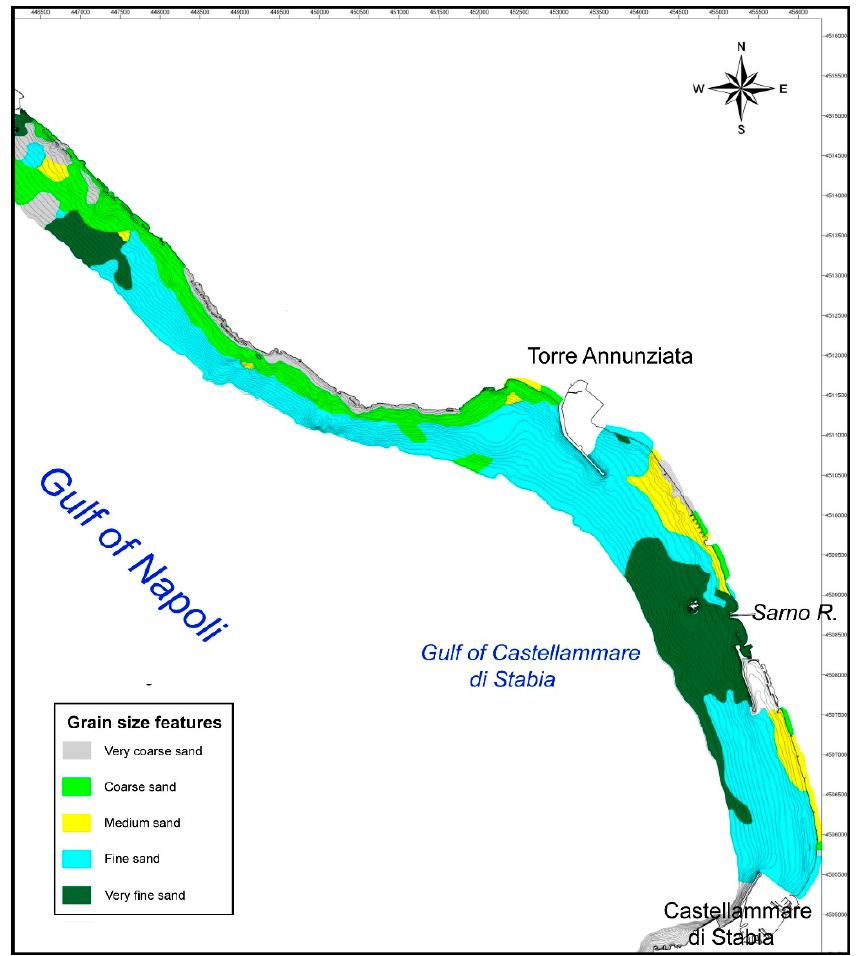
Figure 12. Grain size features of sediments and zonation within a 20 m depth.